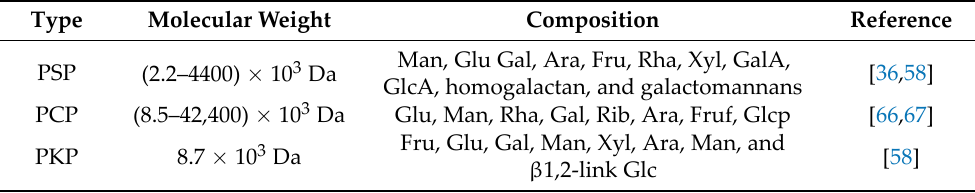
Table 1. Structure comparison among PCP, PKP, and PSP